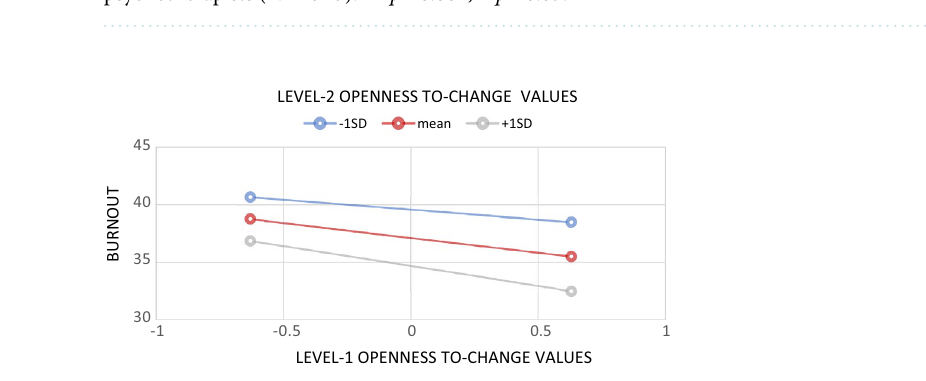
Figure 2. Simple slopes for cross-level interaction for openness-to-change values on burnout. For Level-2 openness-to-change values slopes are probed at a mean and one standard deviation above and below a mean. Level-1 openness-to-change values were centered around within-country